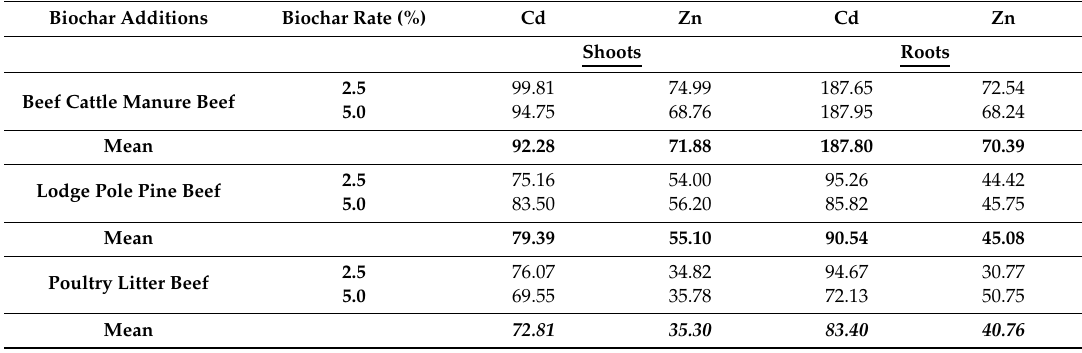
Table 7. Bioconcentration factor of Cd and Zn in corn as a ff ected by di ff erent biochar additions and rates of biochar